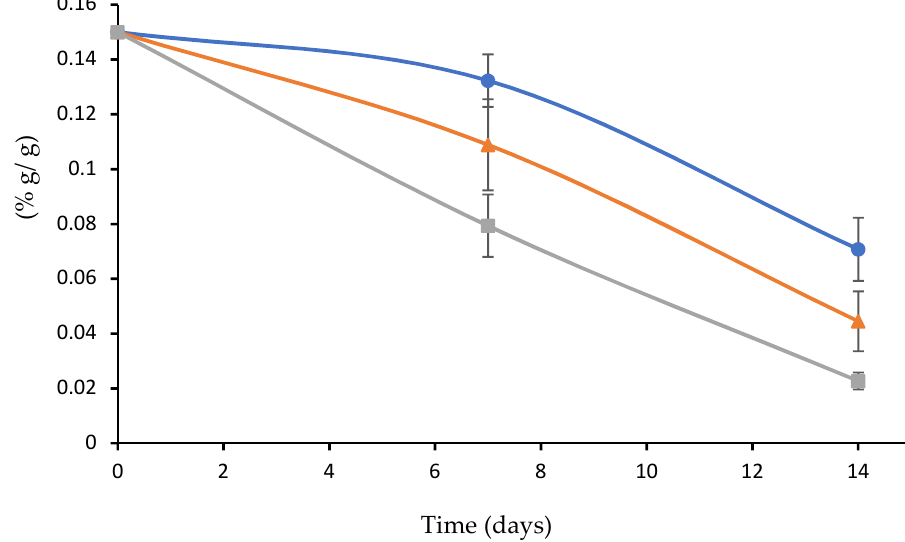
Figure 4. Diesel concentration when the contaminated soil was incubated at 37 °C and inoculated with biofilm attached to plasma-treated wood waste (grey), biofilm attached to untreated wood waste (orange), and planktonic bacteria (blue).